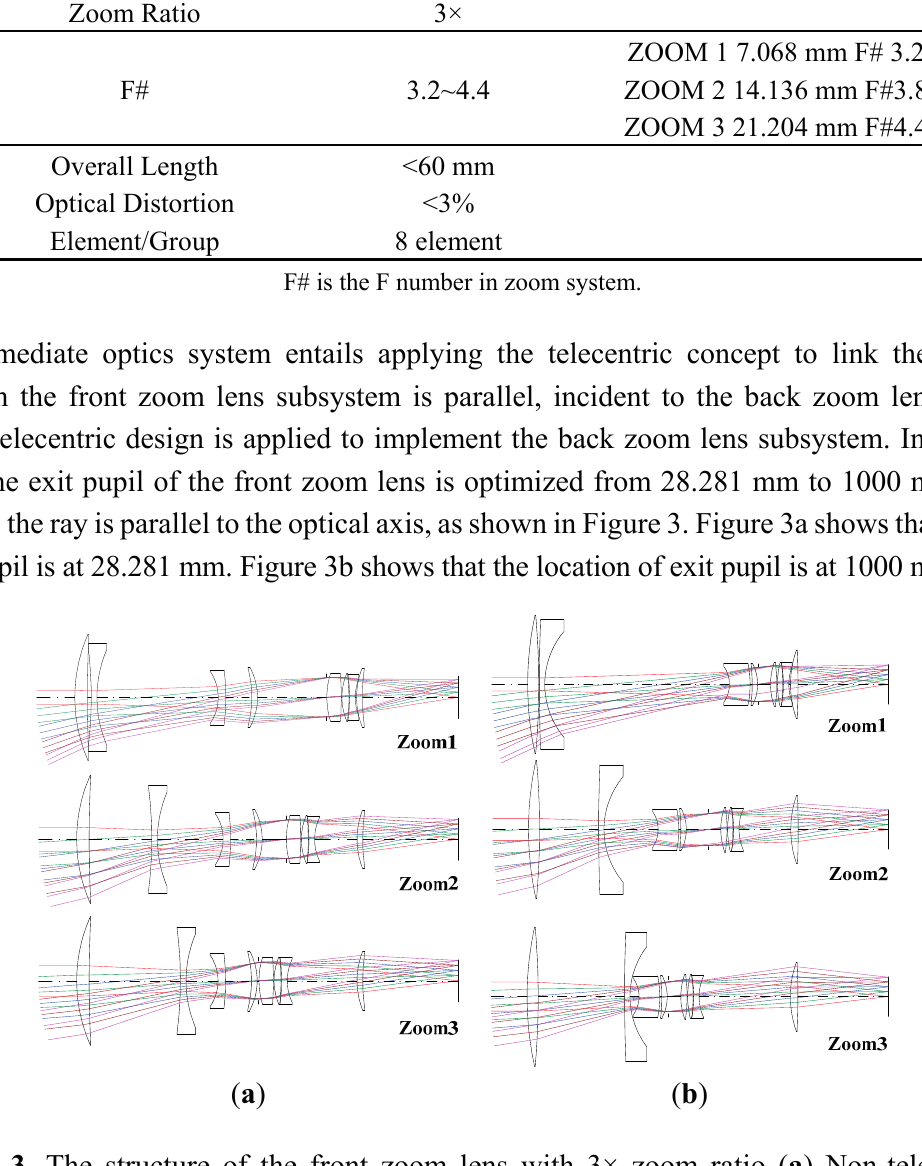
Figure 3. The structure of the front zoom lens with 3× zoom ratio ( a ) Non-telecentric structure; ( b ) Telecentric